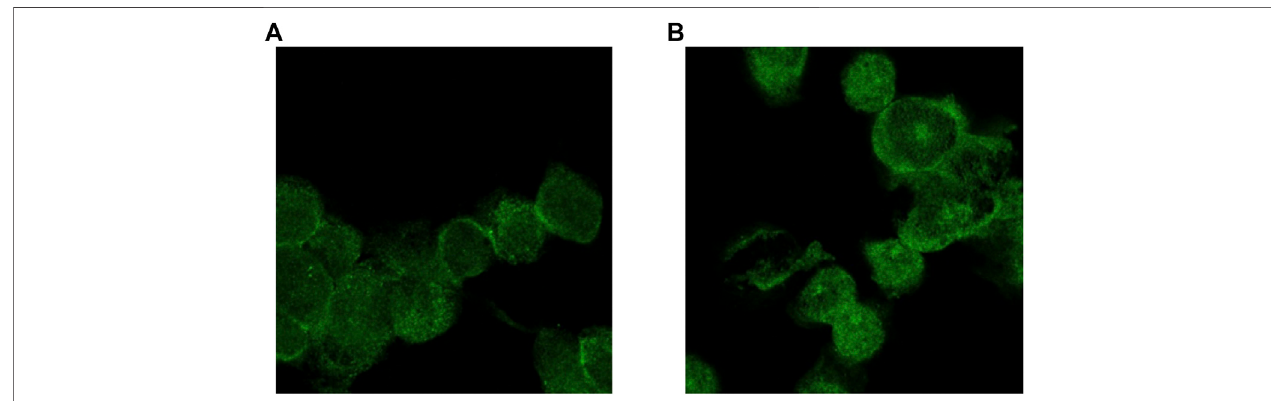
FIGURE4| AdipoR1 and AdipoR2 areexpressed on humanLMs.AdipoR1 (A) and AdipoR2 (B) stainingappears ingreen(AF488 fl uorochrome).Immunostaining was evaluated using a SP5 Leica confocal microscopy (X63) and a spectral imaging acquisition.